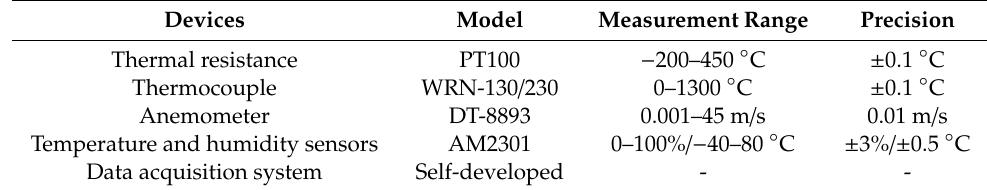
Figure 2. The workflow and schematic diagram of the industrial drying system. Table 2. The details of the experimental instruments.